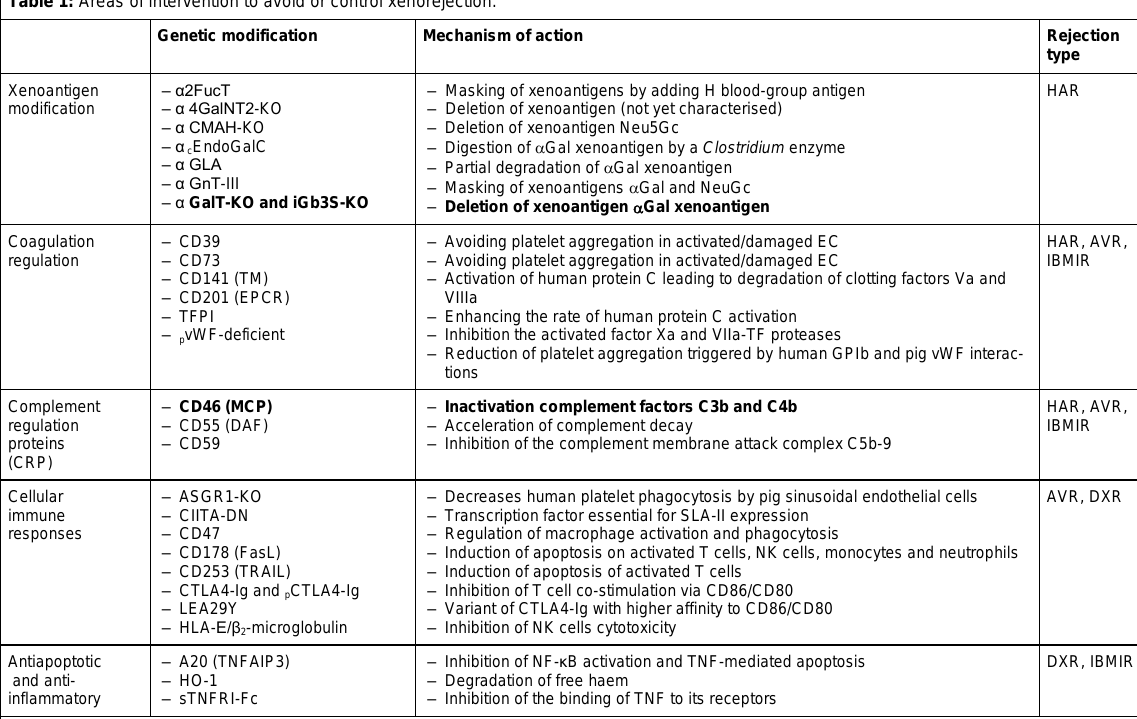
Table 1: Areas of intervention to avoid or control